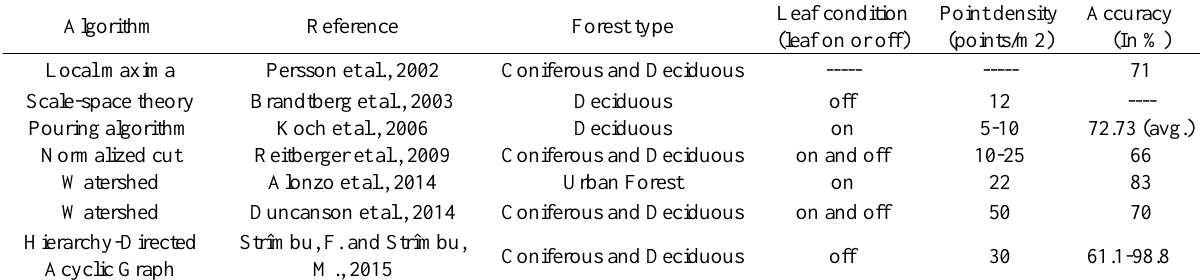
Table 1. Different individual tree detection methods based on LiDAR-derived raster